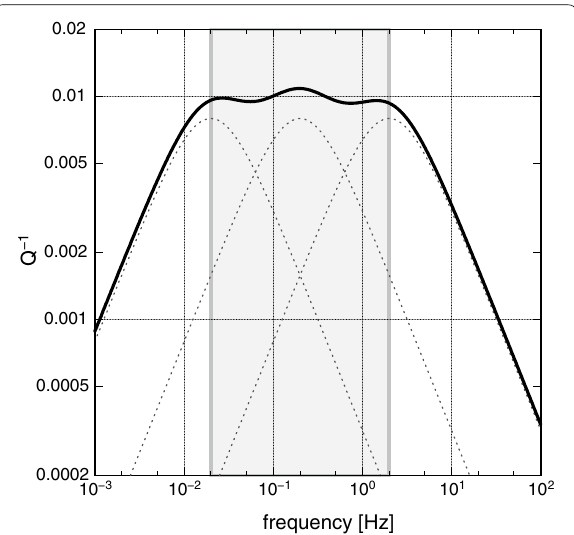
Fig. 2 An example of a nearly constant Q model using three Zener bodies ( bold black curve ), considering a constant Q ( frequency range between 0.02 and 2 Hz. Dotted lines show the contri- butions from three Zener bodies